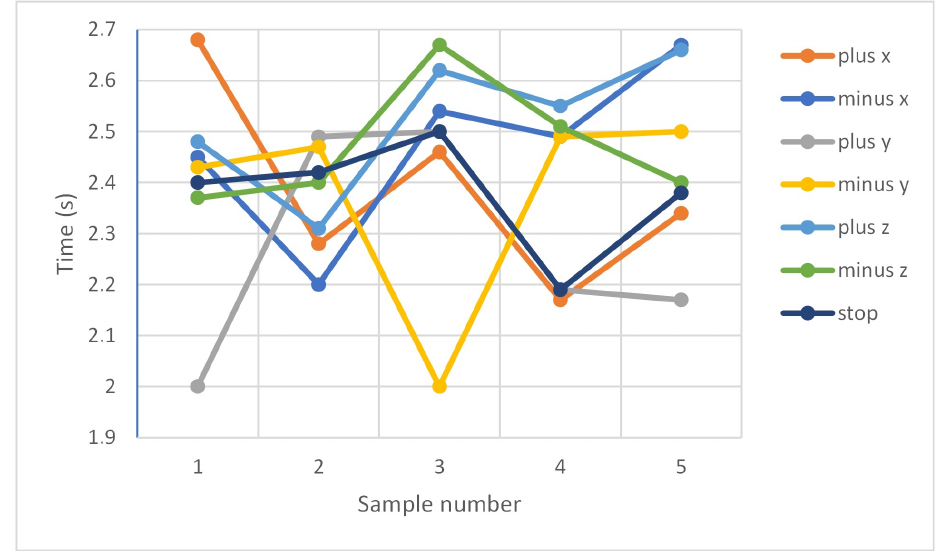
Figure 9. Measurement of the delay of the robot’s reaction to the voice command: virtual